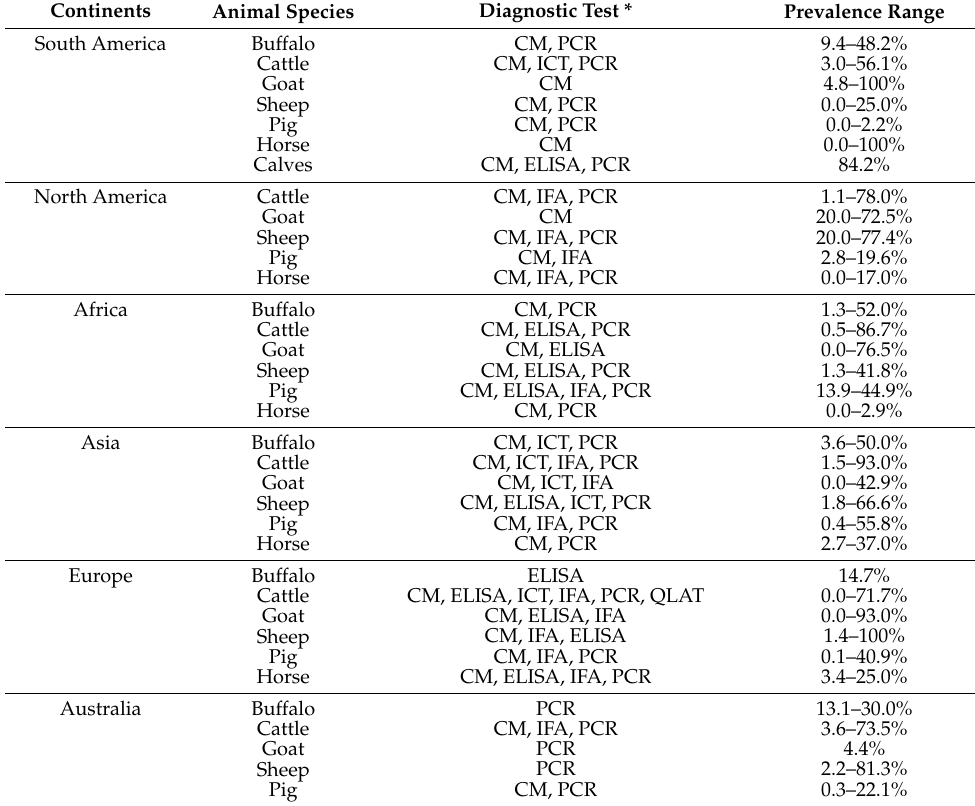
Table 2. Cryptosporidium prevalence in livestock animals in different continents